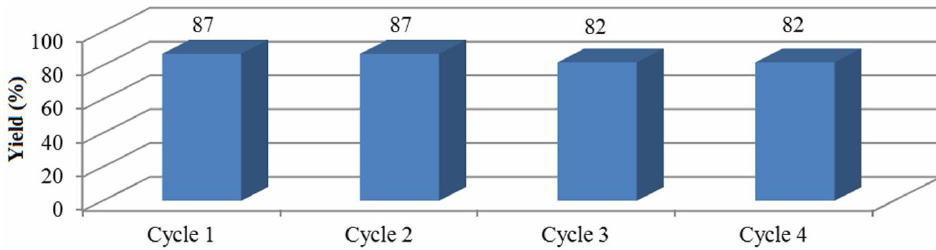
Fig. 3. Development of the yield after several recycling cycles of the